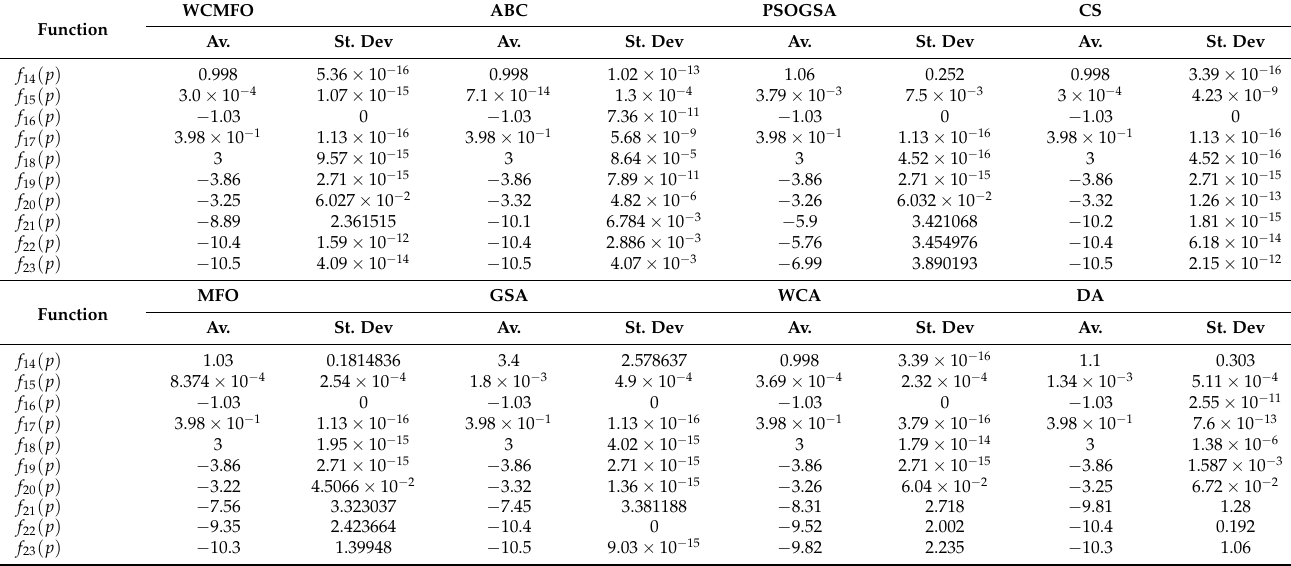
Figure 5. Convergence profile for function 𝑝 (cid:2876) . Figure 6. Convergence profile for function 𝑝 (cid:2869)(cid:2871) .